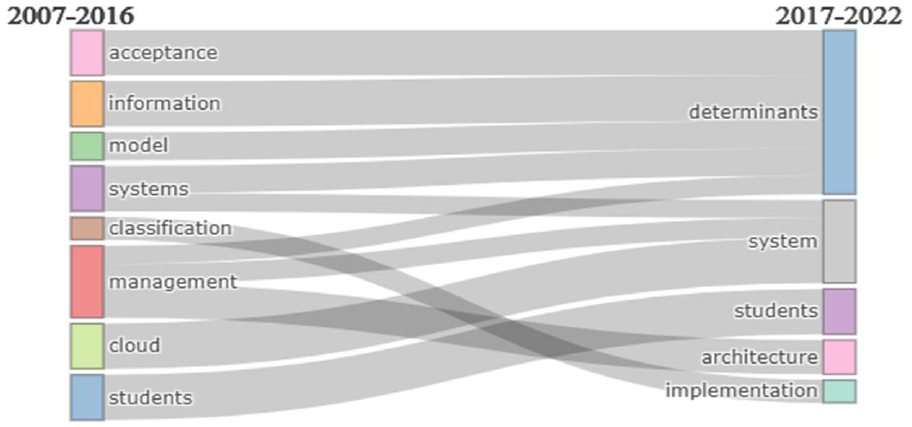
Figure 10. Thematic evolution of authors’ keywords.